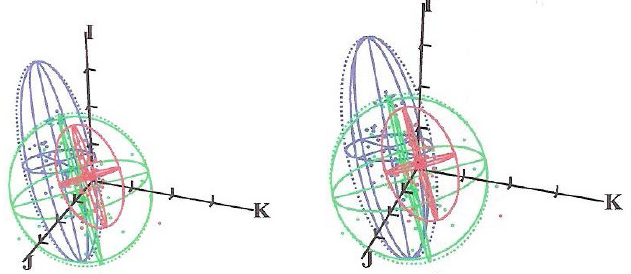
Figure 6: Stereo-pair scatter plot of fifty measurements of refractive state taken from subject 5. The origin of the axes is at 0.5 I D.